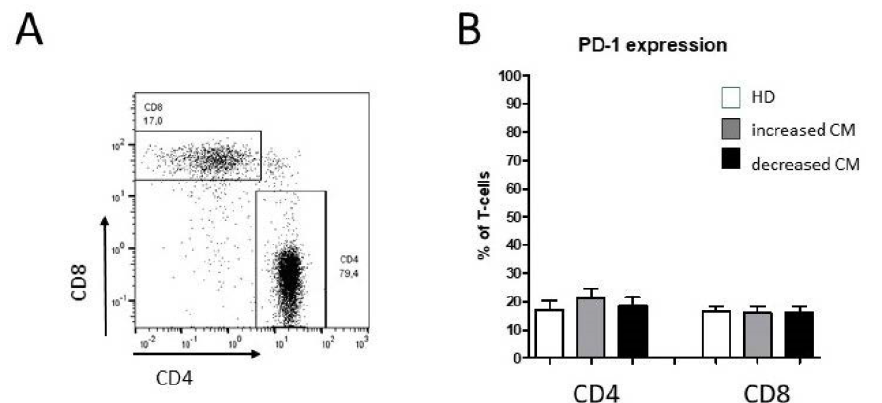
Figure 3. Flow cytometric analysis of CD4 + and CD8 + T cells in PBMCs from healthy donors and oropharyngeal cancer patients. ( A ) Example gating scheme of CD4 + and CD8 + T cells from one representative patient. ( B ) Percentages of PD-1 + cells within both the CD4 + and CD8 + T -cell